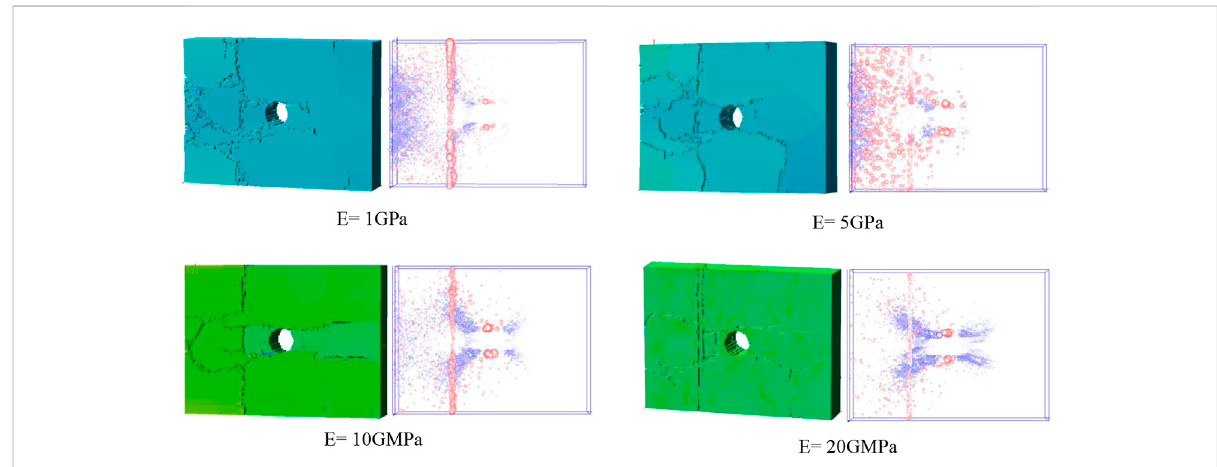
FIGURE 7 Failure patterns and AE distribution of jointed rocky with a pre-existing hole under different joint